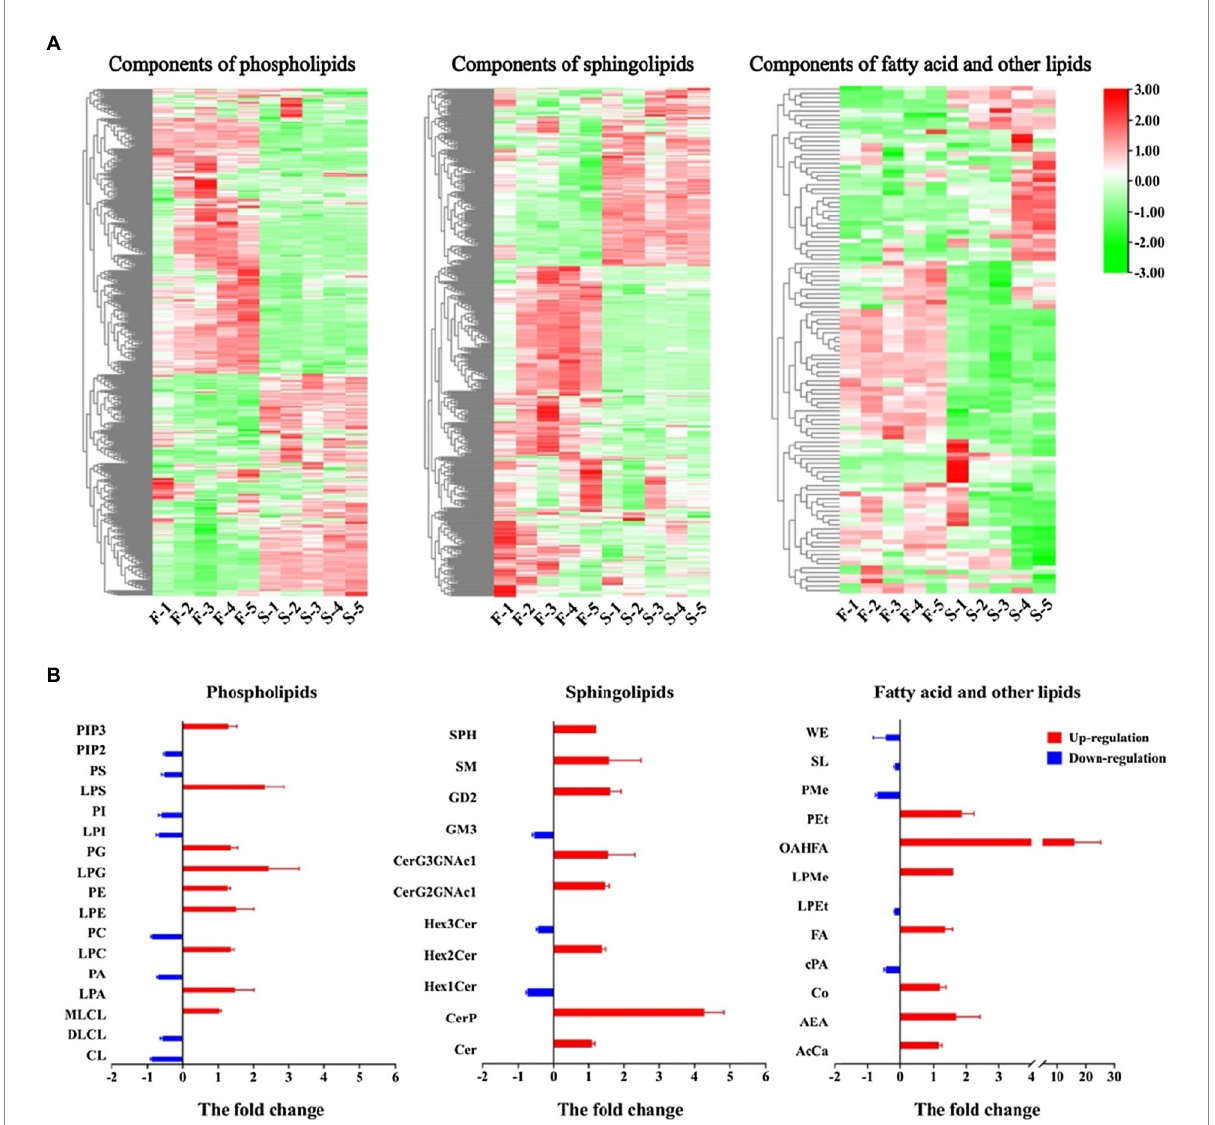
FIGURE 5 Differences in lipid metabolites were compared in fertile and sterile anthers. (A) Cluster heat map of different components in lipids. (B) The change of phospholipids, sphingolipids, fatty acids and other lipids in the comparative group. In B , the Y -axis indicates the different lipids and the X -axis indicates the fold change of lipid in the comparison group of fertile and sterile plants. Red bars indicate that the lipid is upregulated in fertile plants and blue bars indicate that the lipid is downregulated in fertile plants. The full names of the abbreviations in the classification were shown in the abbreviated list (Supplementary Table